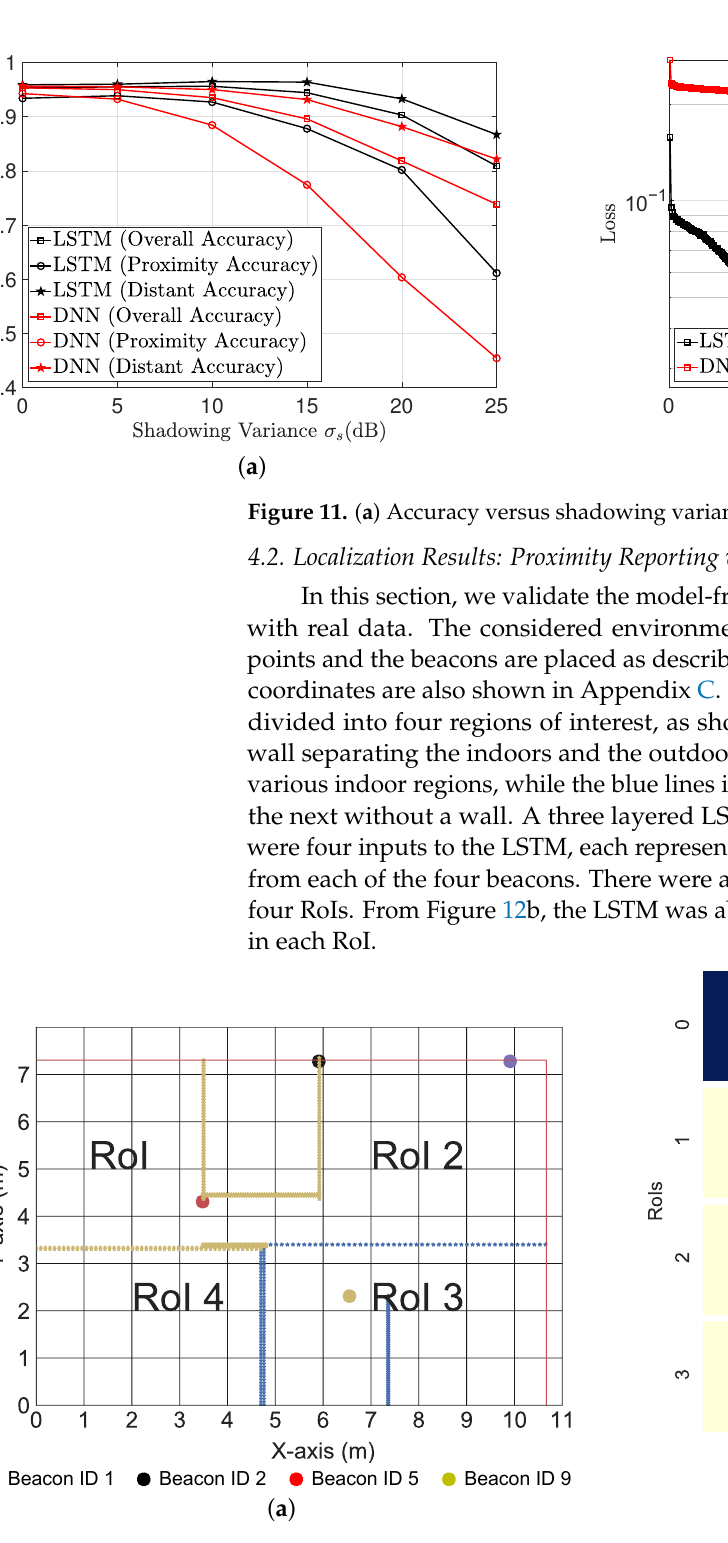
Figure 12. ( a ) Floor plan, showing the beacon locations and the regions of interest; ( b ) confusion matrix showing accuracy of neural network-based proximity